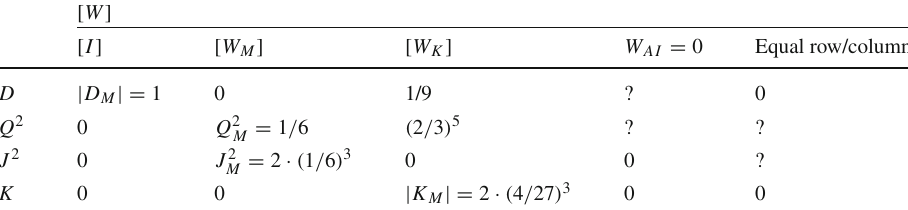
K ) for special [ W ] ’s. W AI = 0 denotes a matrix [ W ] with a zero anywhere. Equal row/column indicates that any two rows or columns are the same. [ W M ] and [ W K ] are defined in Eqs. (57) and